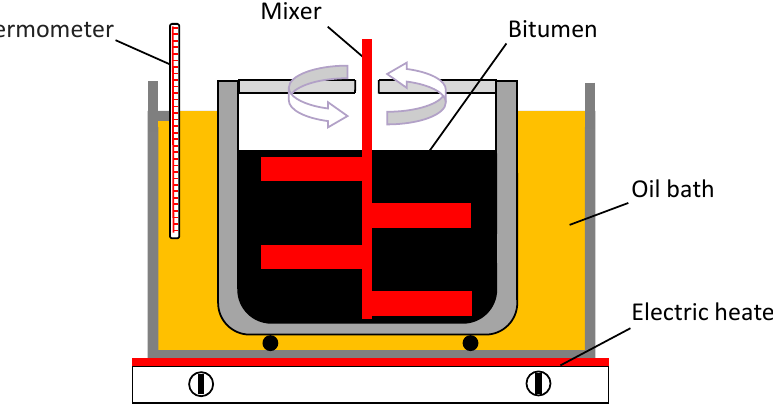
Figure 5. Modification of bituminous binder with SBS copolymer in oil bath.